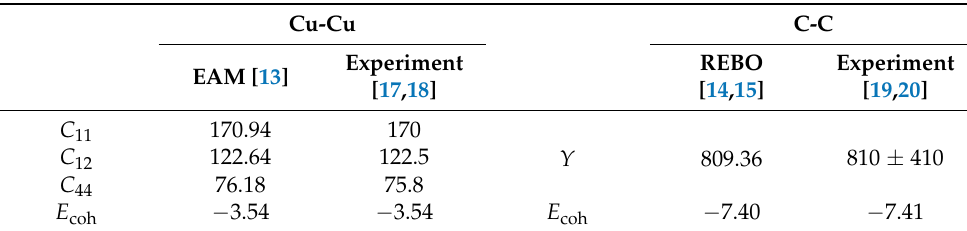
Table 1. Comparison of the stiffness and cohesive energy of the materials between simulation data and experimental values. The SI unit of the stiffness C ij and Young’s modulus Y is GPa. The SI unit of the cohesive energy E coh is eV/atom. The chiral vector of the CNT utilized in the table is